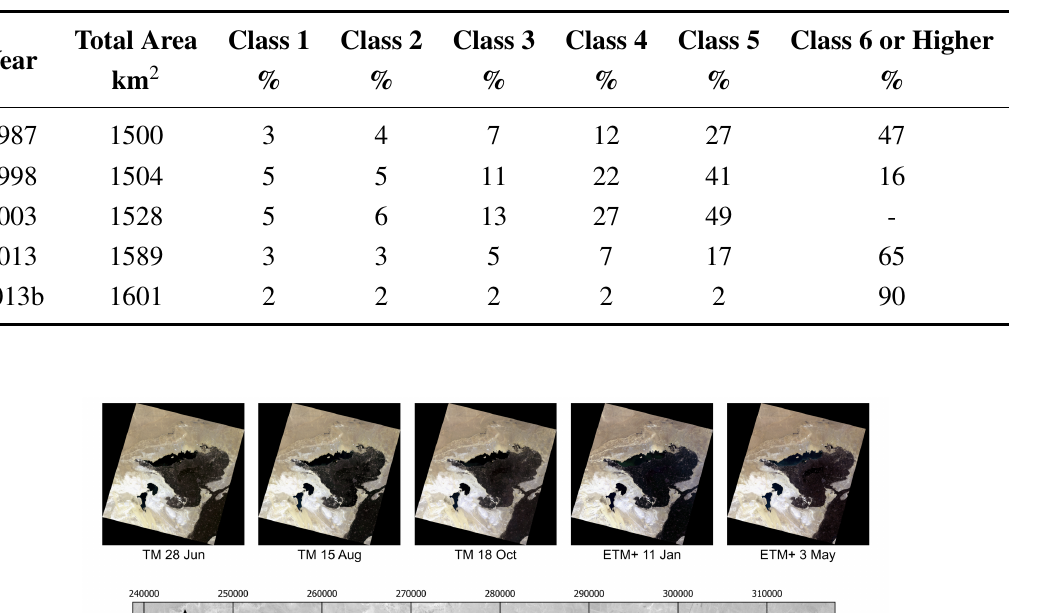
Table 2. Extension of the cultivated fields in the four years under examination and areal percentage of each class (the class number indicates how many times the pixel was classified as vegetated during the same year). For 2013, the first solution made use of six images only